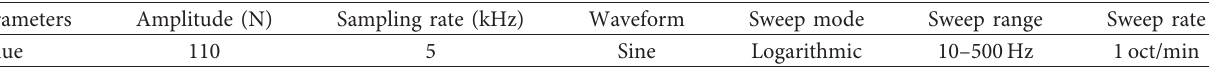
Table 6: Parameters of the excitation signal.